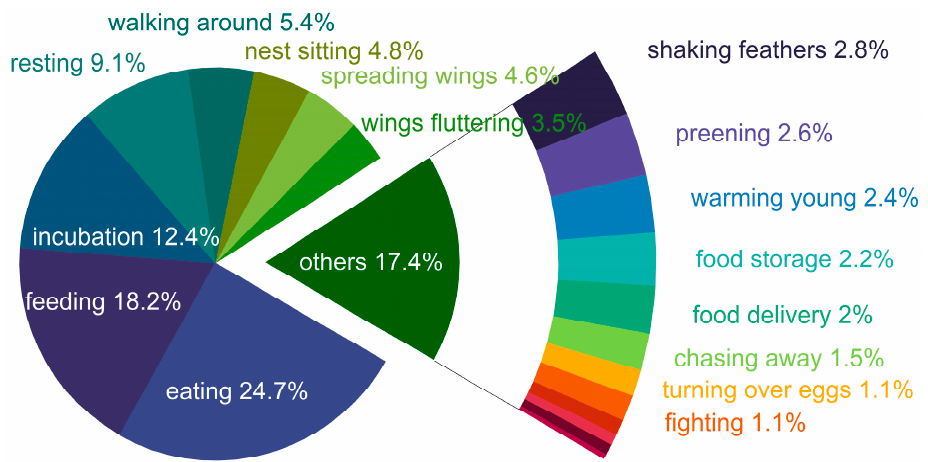
Figure 3. Proportion of activities portrayed in the TikTok Videos.